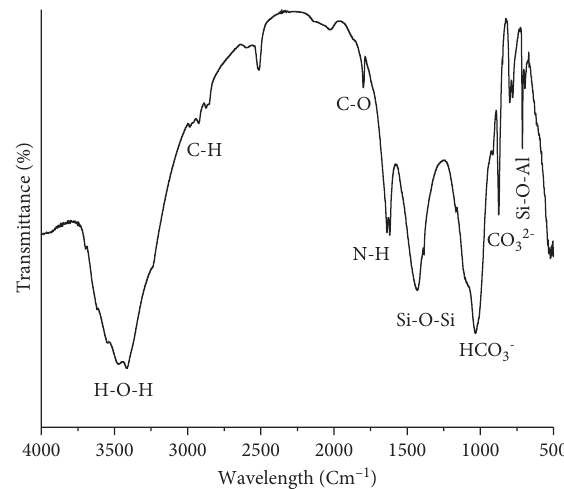
Figure 1: X-ray diffraction of Oued Sebou sediment. Figure 2: Infrared spectrum of Oued Sebou